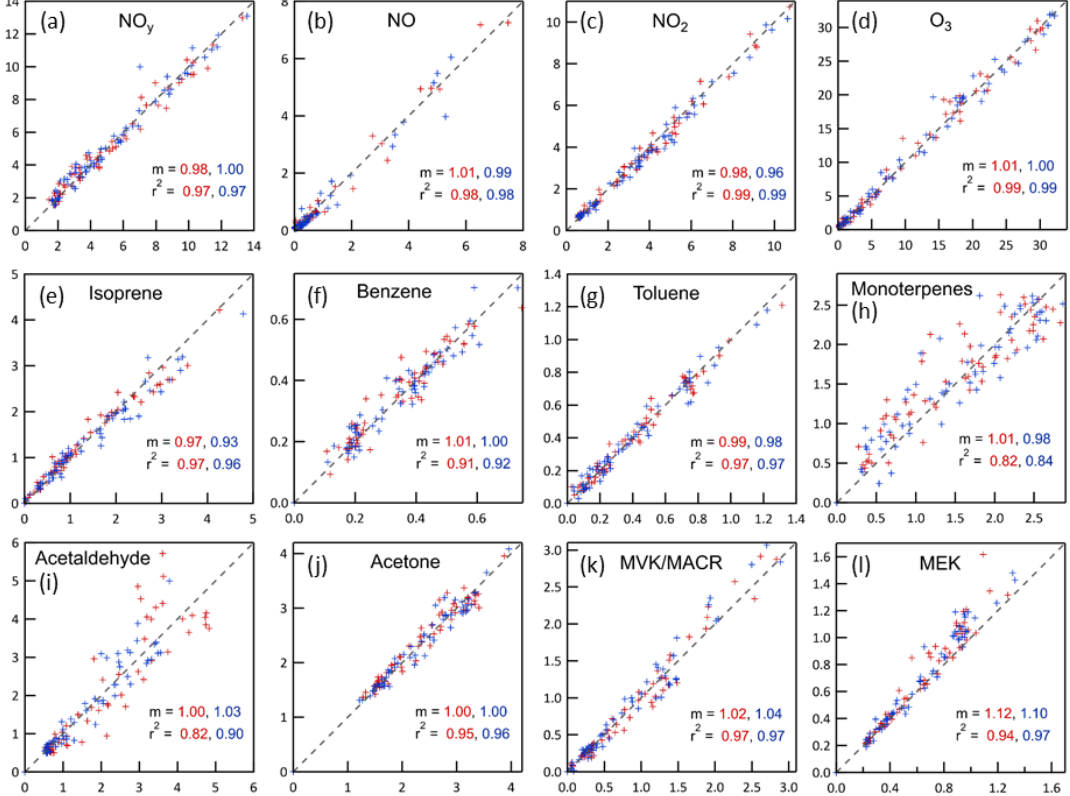
Figure 6. Relationships between mixing ratios (ppb) expected in the chambers calculated from the ambient time series using the CSTR 0D model ( x -axes) and measured in the chambers ( y -axes). For all graphs, the red markers and text are for Chamber A and the blue are for Chamber B. The dashed lines shown in all graphs are 1 : 1 lines. The slopes, m , are for best fit lines forced through the origin. MVK/MACR = methyl vinyl ketone/methacrolein, both of which are measured at the same mass by the PTR-MS. MEK = methyl ethyl